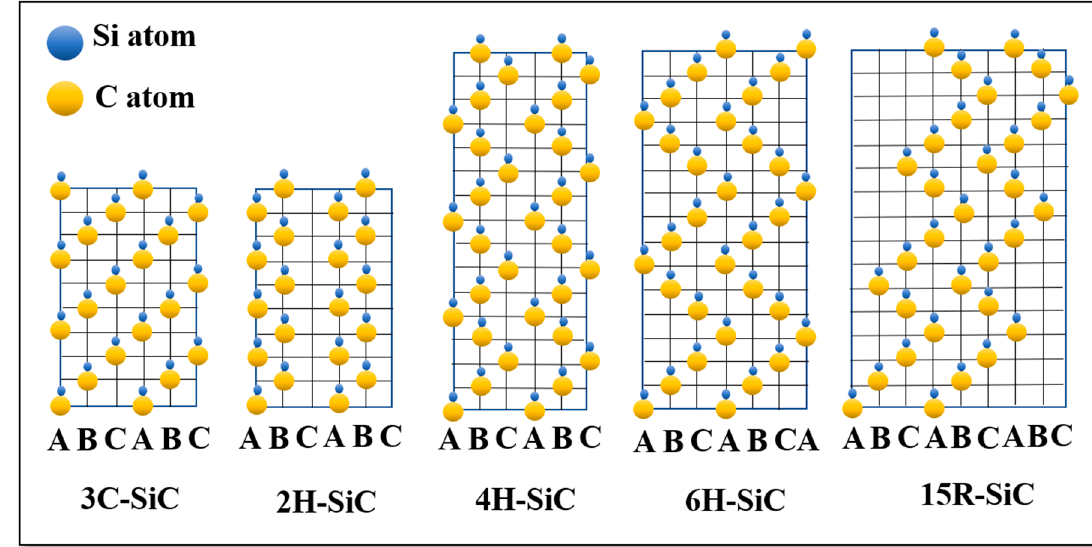
Figure 2. Stacking Si-C bilayer in the plane (1120) along the vertical axis (0001) for the most common polytypes, where the atomic plane positions in each polytype are described as A, B and C. The modification in the direction from right to left in the stack corresponds to the intercalation of an opposite tetrahedron in relation to those of the lower bilayer.